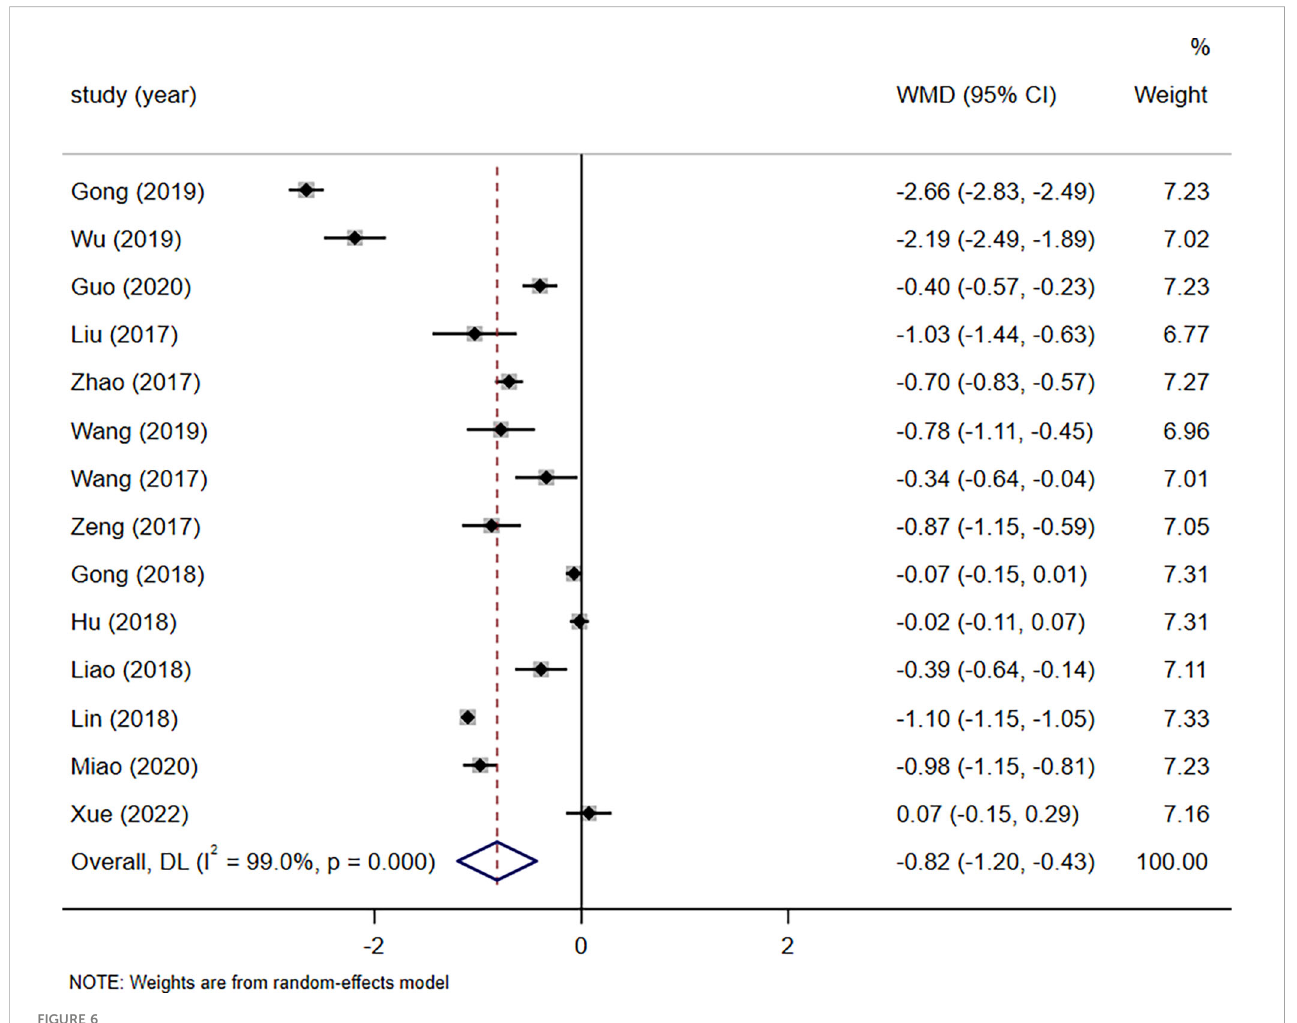
FIGURE 6 Impact of ERAS on patient hospitalization